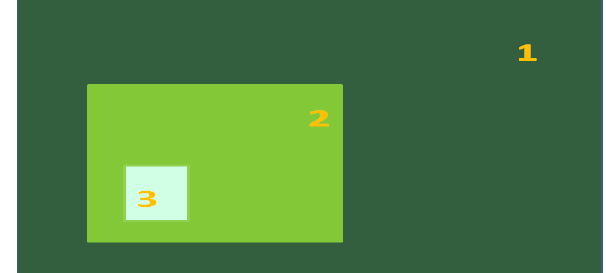
Figure 3 – The Three_Stage Analysis Procedure